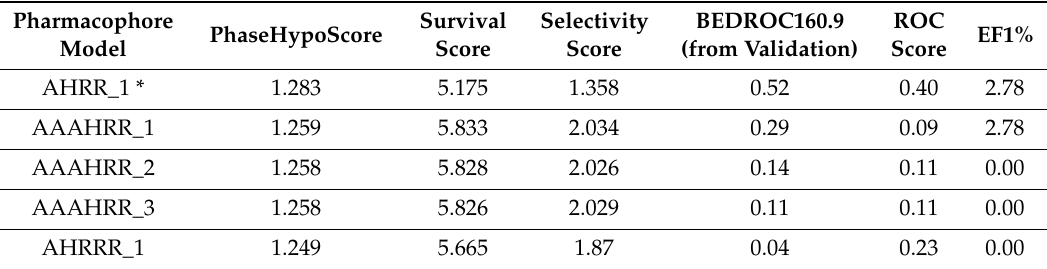
Table 10. Top 5 pharmacophore hypotheses for the 1,2,4-triazole set. A–acceptor group; H–hydrophobic group; R–aromatic group.